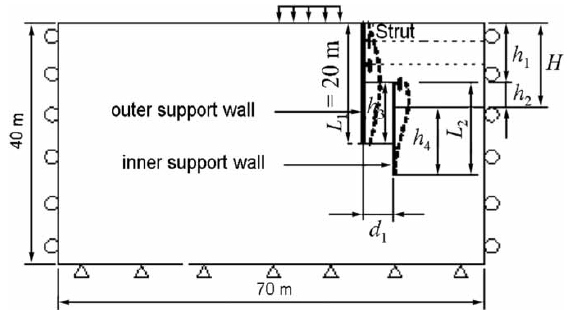
Fig. 1. Schematic of double-row support structure and model of